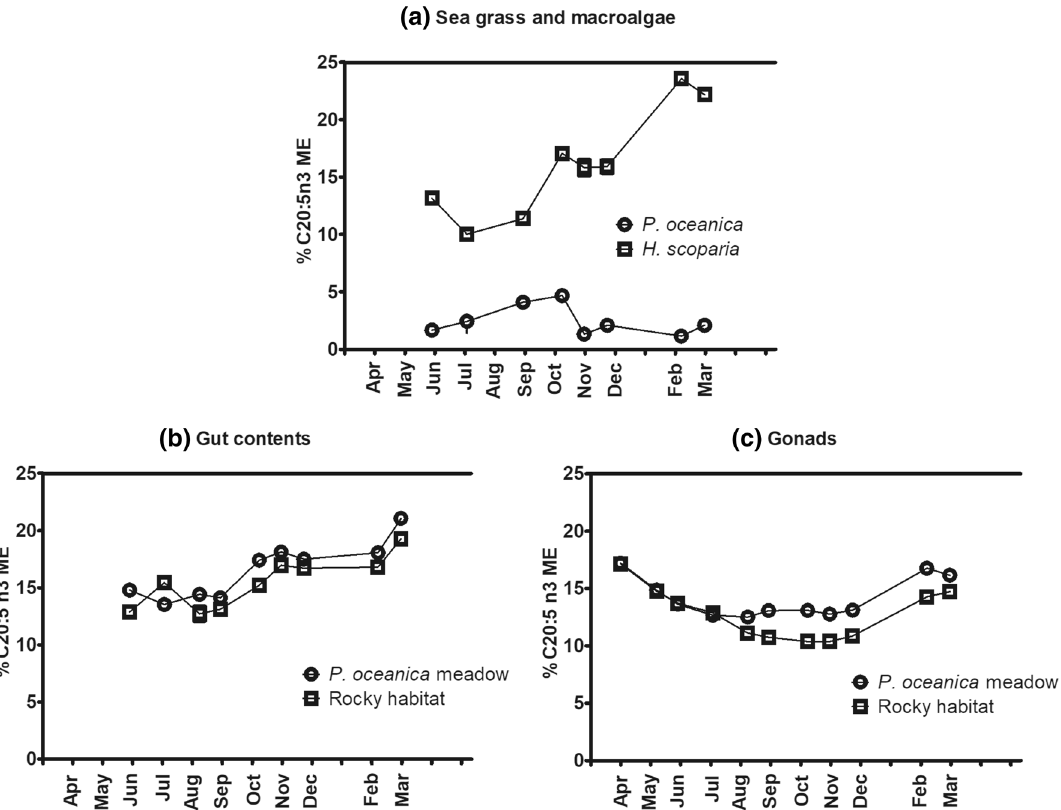
Figure 6. Seasonal variation of C 20:5 (n-3) in the most representative dietary sources ( a ), gut contents ( b ) and gonads ( c ) of P. lividus from P. oceanica meadow and rocky bottom. Each point corresponds to the analysis of a pooled sample, as detailed in “Materials and methods”